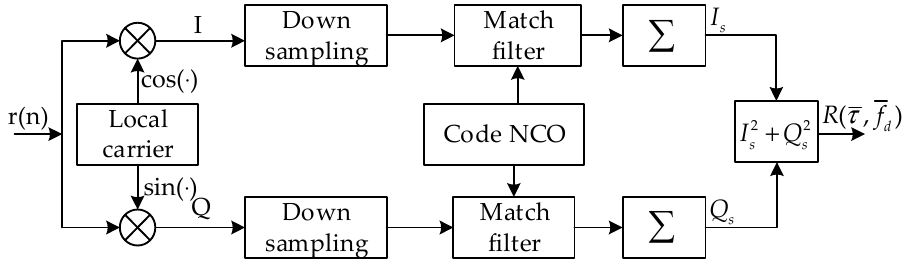
Figure 7. Flowchart of the matched filter method.